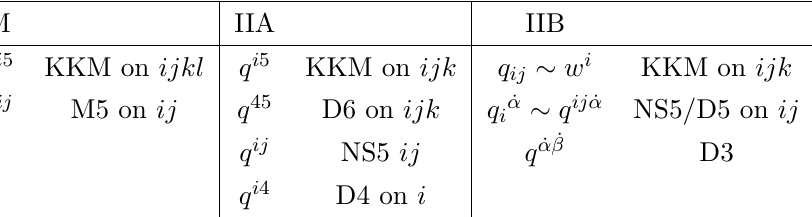
Table 4 . Partially wrapped branes (membranes): q a .